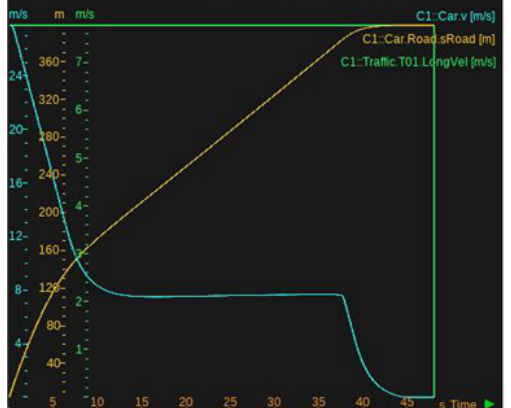
Figure 17. The visualisation of the collision avoidance and velocity of Tesla S is 0